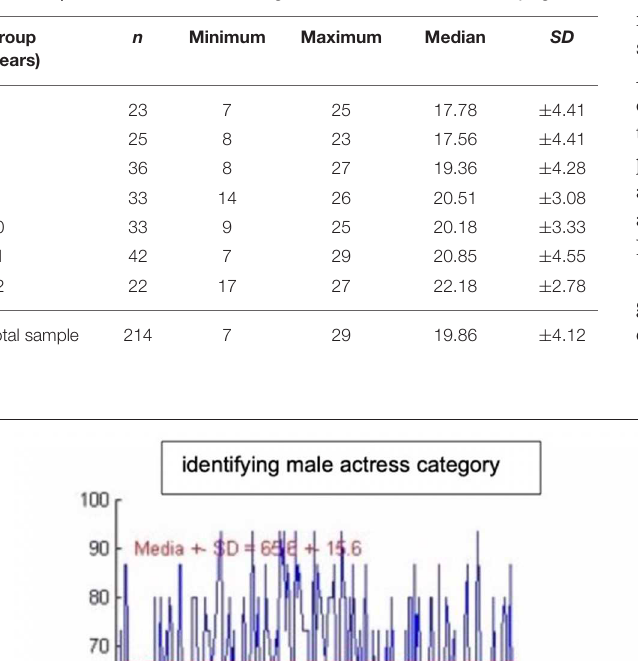
TABLE 2 | Normative data test of recognition of emotion in childhood by age.